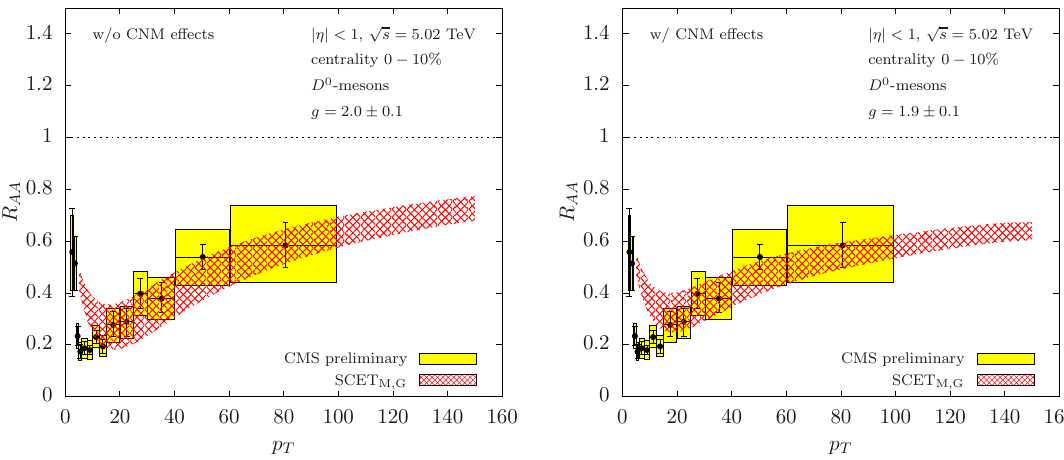
Figure 12 . Nuclear modi(cid:12)cation factor R AA for D 0 mesons without (left) and with (right) CNM e(cid:11)ects in comparison to preliminary the CMS data of [13]. We have and 0 (cid:0) 10% centrality. When CNM e(cid:11)ects are (not) included, we choose the coupling strength as g = 1 : 9 (cid:6) 0 : 1 ( g = 2 : 0 (cid:6) 0 :